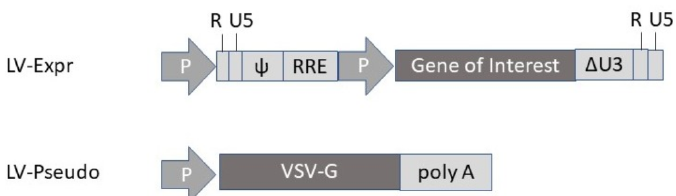
Figure 3. Lentivirus expression vector (LV-Expr) and envelope-expressing vector for production of pseudotyped lentivirus (LV-Pseudo) particles with vesicular stomatitis virus glycoprotein (VSV-G) envelope. P, promoter; ψ , packaging signal; RRE, Rev response element; ∆ U3, deletion.